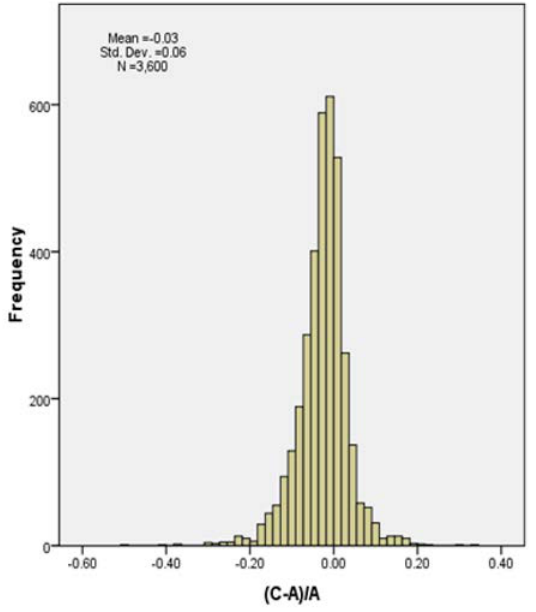
Figure 4. Comparison of PHF Computed by Approaches A and C